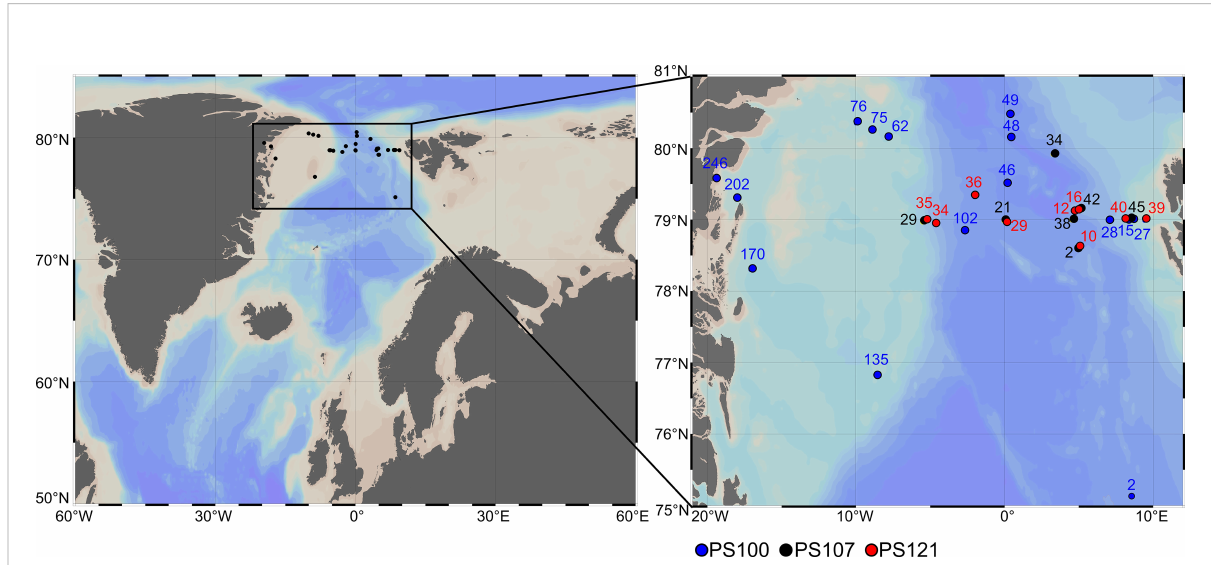
FIGURE 1 Location of stations where zooplankton specimens were collected for respiration experiments during cruises PS100, PS107 and PS121. Numbers above dots indicate respective station